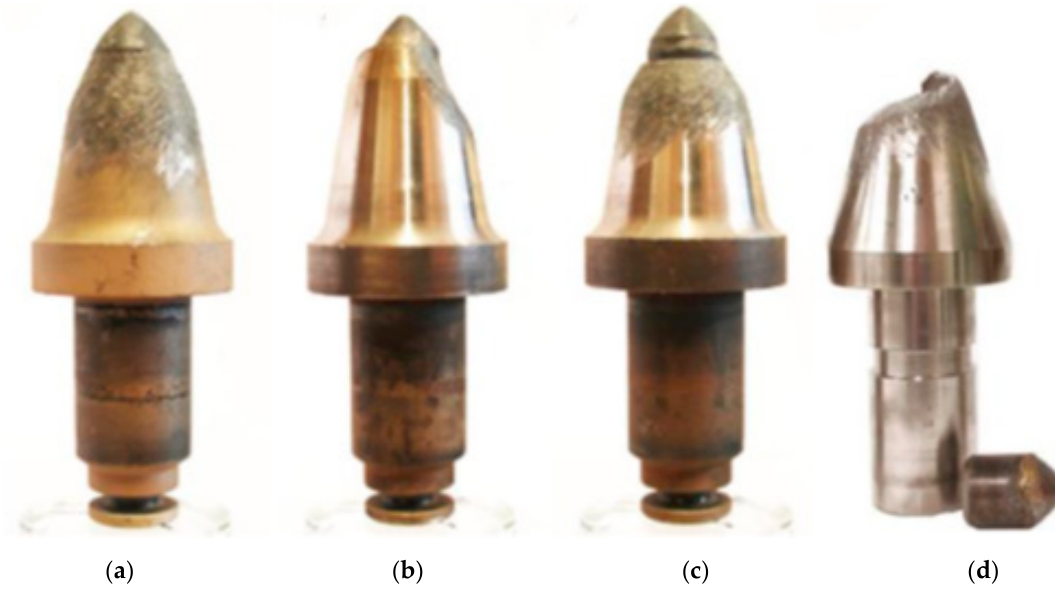
Figure 3. Worn conical picks: ( a ) properly (symmetrical); ( b ) improperly (asymmetrical); ( c ) with the tip exposed; and ( d ) with the tip falling out [37].